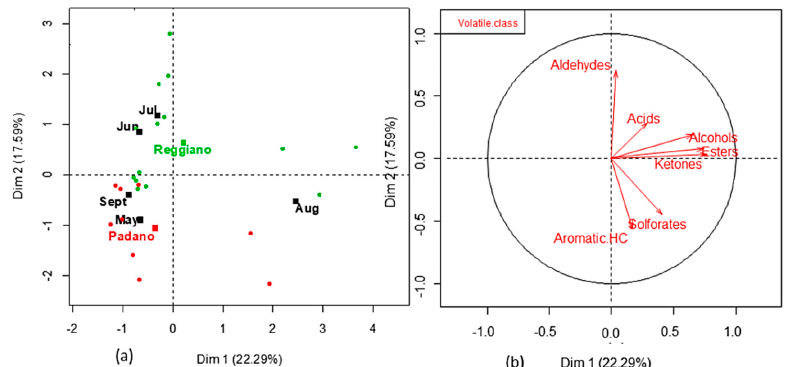
Figure 1. Projection of factors (month-milk destination) (a) , and the volatile class (b) in the first two dimensions calculated with the MFA technique. Aromatic HC: aromatic hydrocarbons.